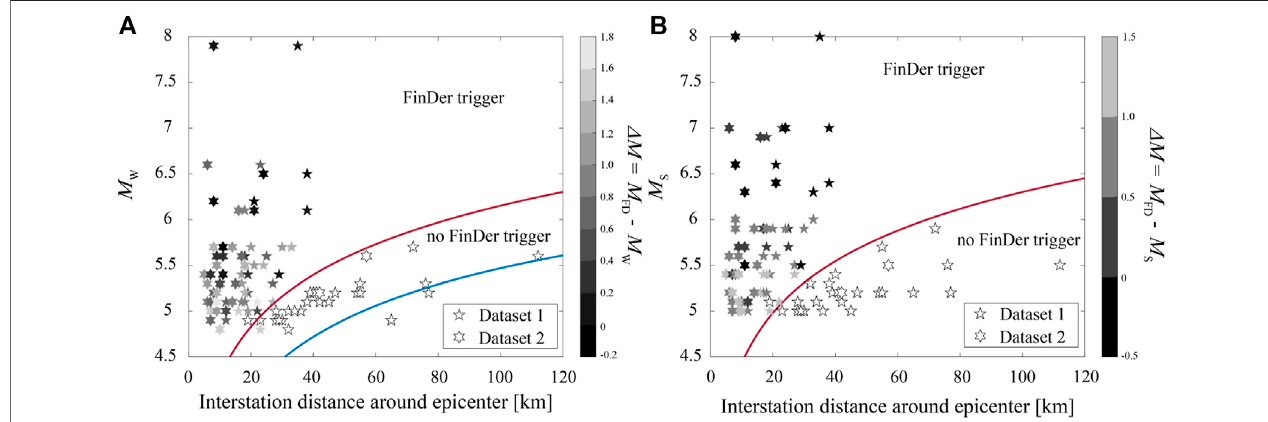
FIGURE 7 | Testing FinDer trigger settings (4.6 cm/s 2 at neighboring three stations) for all 58 earthquakes as a function of interstation distance, D epi , and (A) moment magnitude, M W (here of GCMT) and (B) surface-wave magnitude, M S (here of CENC), respectively. D epi is de fi ned as the average distance between the epicentertothethreecloseststations.ThebluelineshowstheGMPEofCuaandHeaton(2009)forPGA (cid:1) 4.6 cm/s 2 .Thetworedlinesillustratetheboundarycondition: FinDer is expected to trigger, if D epi ≤ log 10 ( M a + b )+c, where a (cid:1) 1.91, b (cid:1) 5.93, and c (cid:1) 2.34 for M (cid:1) M W ≥ 4.8, and c (cid:1) 2.49 for M (cid:1) M S ≥ 5.0, respectively. The datasets used here, however, cannot fully constrain these relationships, and our boundary conditions provide a rough estimate